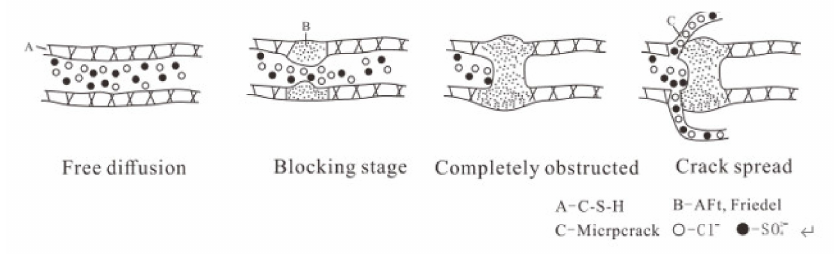
Figure 15. Cl − diffusion process in